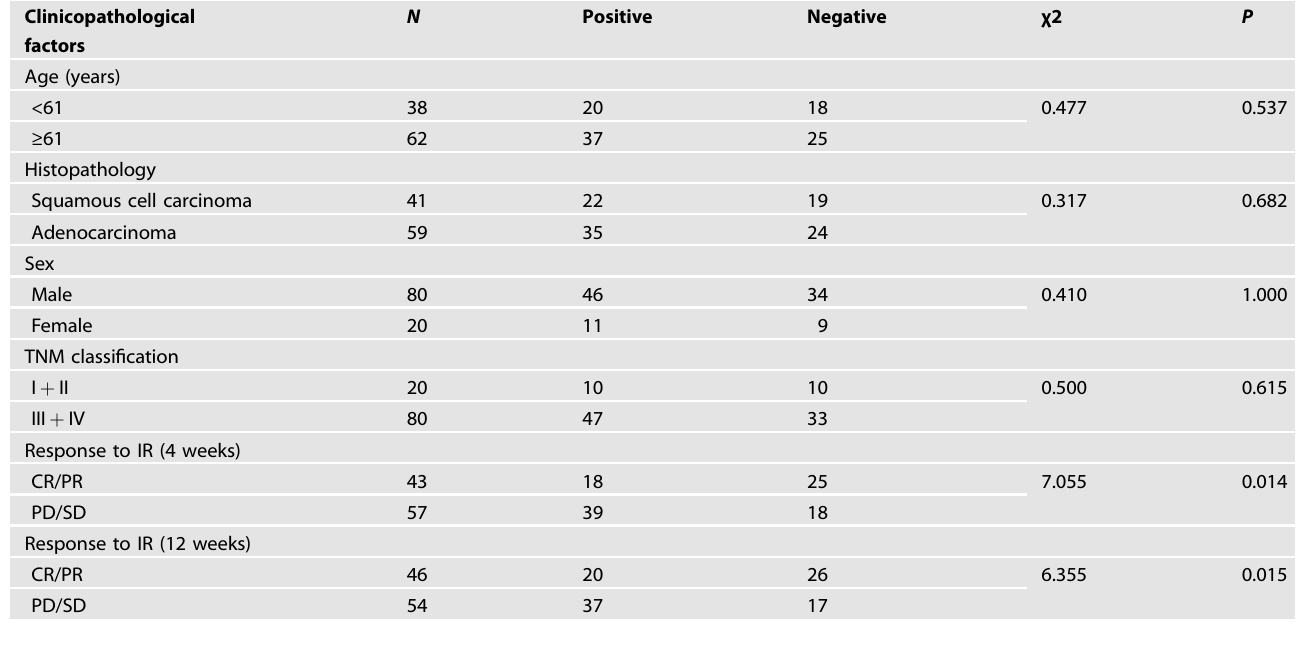
Table 4. Correlation of the expression of P130cas with clinicopathological features as well as response to radiotherapy in 100 cases of non-small cell lung